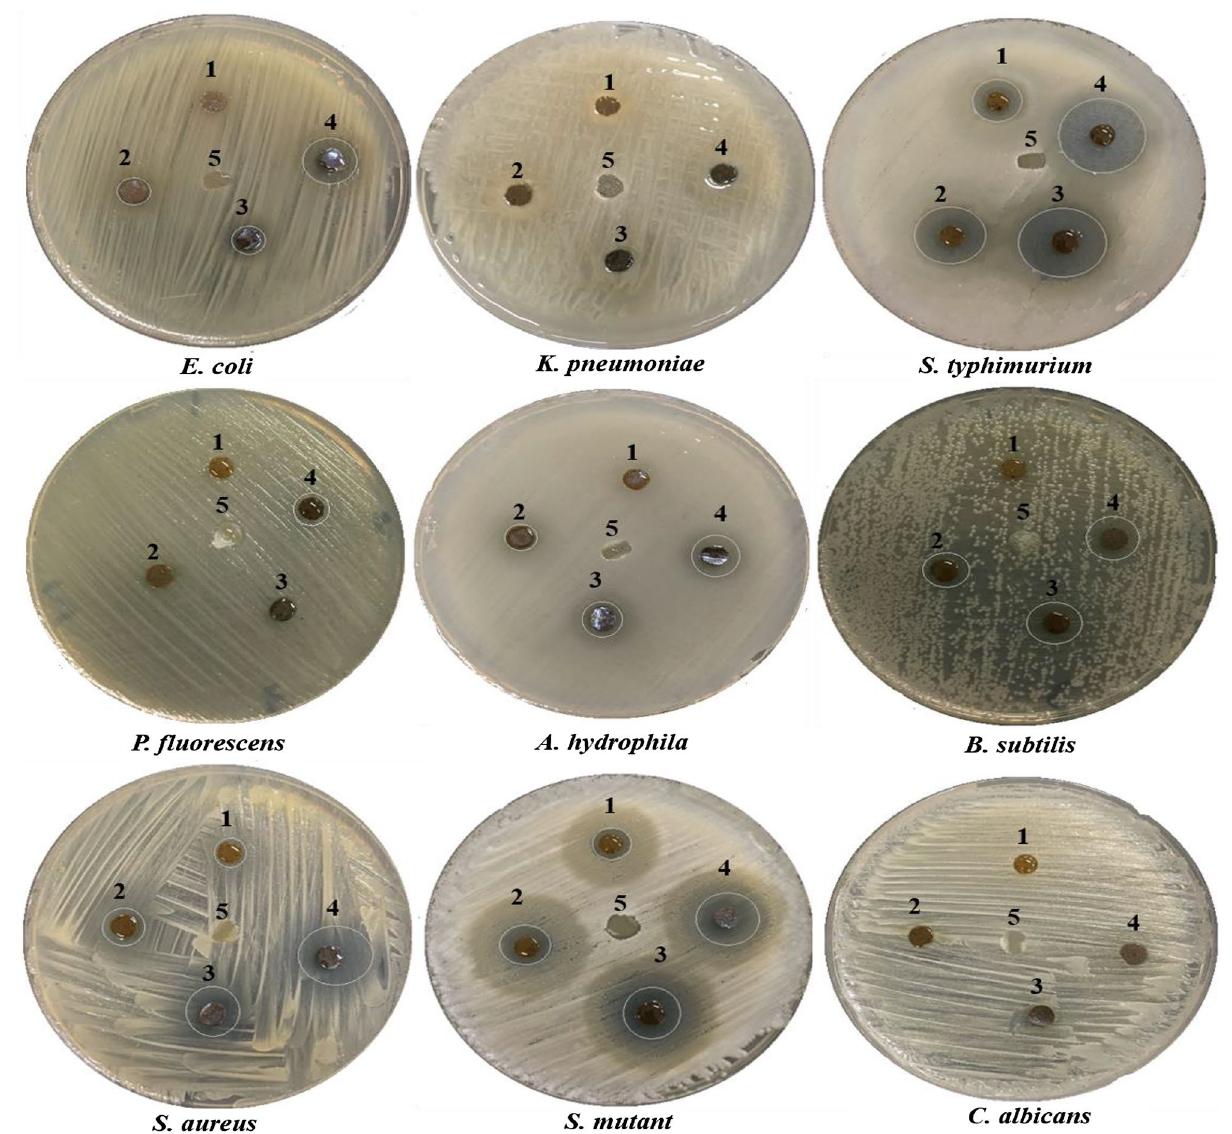
Figure 12. Disk diffusion method for antimicrobial activity expressed as halo-zones of the prepared BC/PVA/ Ch at four CuO-NPs concentrations including: 1 (0.025), 2 (0.050), 3 (0.075), and 4 (0.100) compared with 5 (CuO-NPs/free BC/PVA/Ch) against nine pathogenic microorganisms.